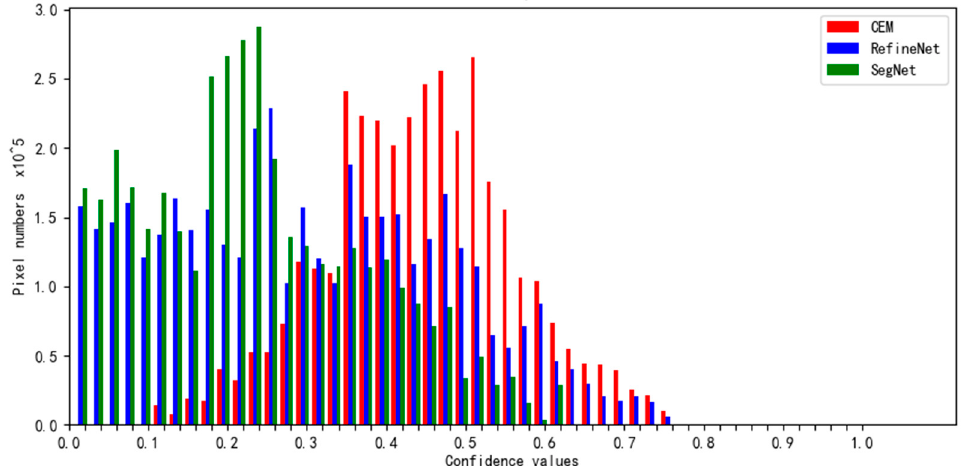
Figure 8. The category confidence distribution for the results of the experiment.